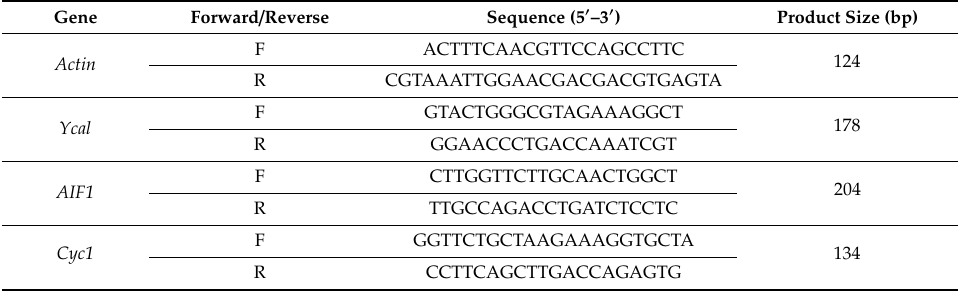
Table A1. Oligonucleotides for